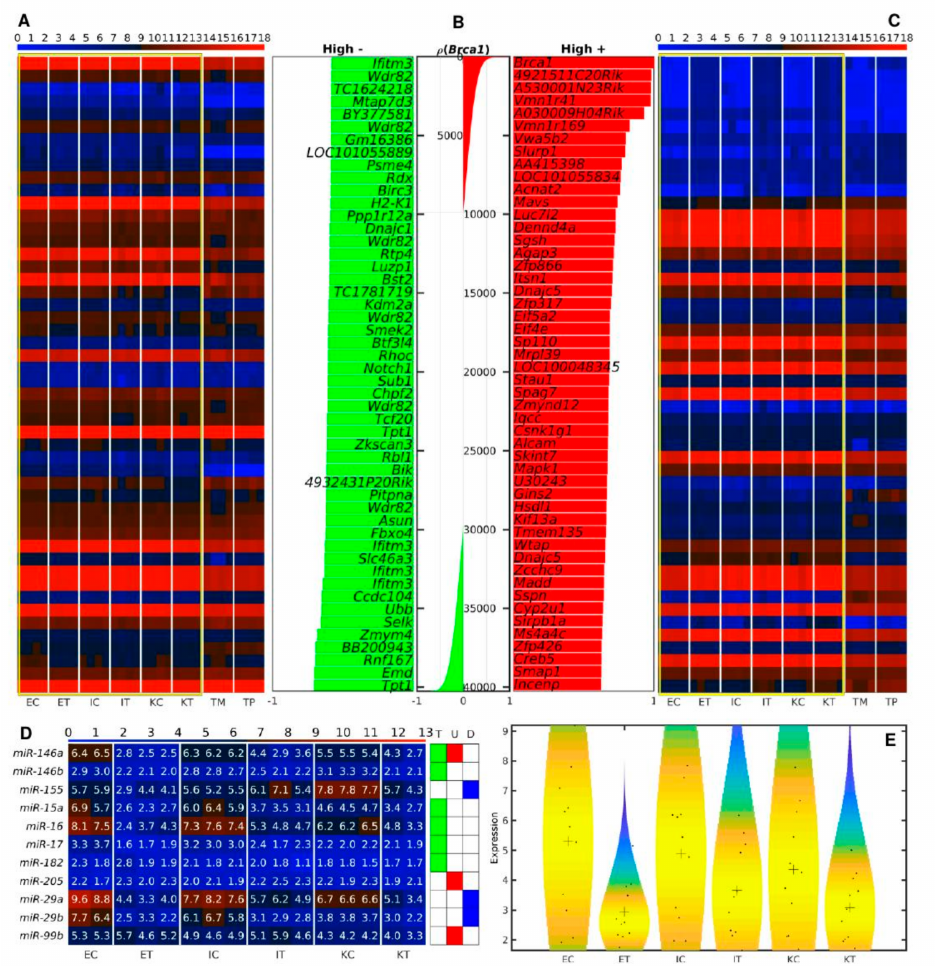
Figure 4. Gene expression correlation with Brca1 . Heatmaps of the expression of the 50 top-ranked genes: ( A ) negatively or ( C ) positively correlated with the expression of Brca1 a cross all samples. Color bars codify the gene expression on a log2 scale. Higher gene expression corresponds to a redder color. Yellow frames mark the samples used to calculate the correlations. ( B ) Bar plots of the gene-expression correlation with Brca1 . The central panel depicts the correlation of the expressions of all genes with the expression of Brca1 . Left and right panels represent the correlation of the top 50 negatively- and positively-correlated genes, respectively. Green and red colors represent negatively- and positively-correlated genes, respectively. ( D ) Heatmap of the expression of the known Brca1-related miRNAs [24]. T: miRNAs targeting Brca1, U: miRNAs up-regulated by Brca1, D: miRNAs down-regulated by Brca1. ( E ) Violin plots of the expression distribution of the Brca1-related miRNAs. Black crosses represent mean positions. Black points represent the spread of the expression of the genes used to build the distributions. The samples are denoted with E, I, and K for endothelial, Ito, and Kup ff er cells, C and T for control and TME cells, and TP and TM denote the CRC primary and tumor liver metastasis cells, respectively. For each mRNA sample, we used 4 biological replicates, and for each miRNA sample 3 biological replicates, except 2 for ECs and